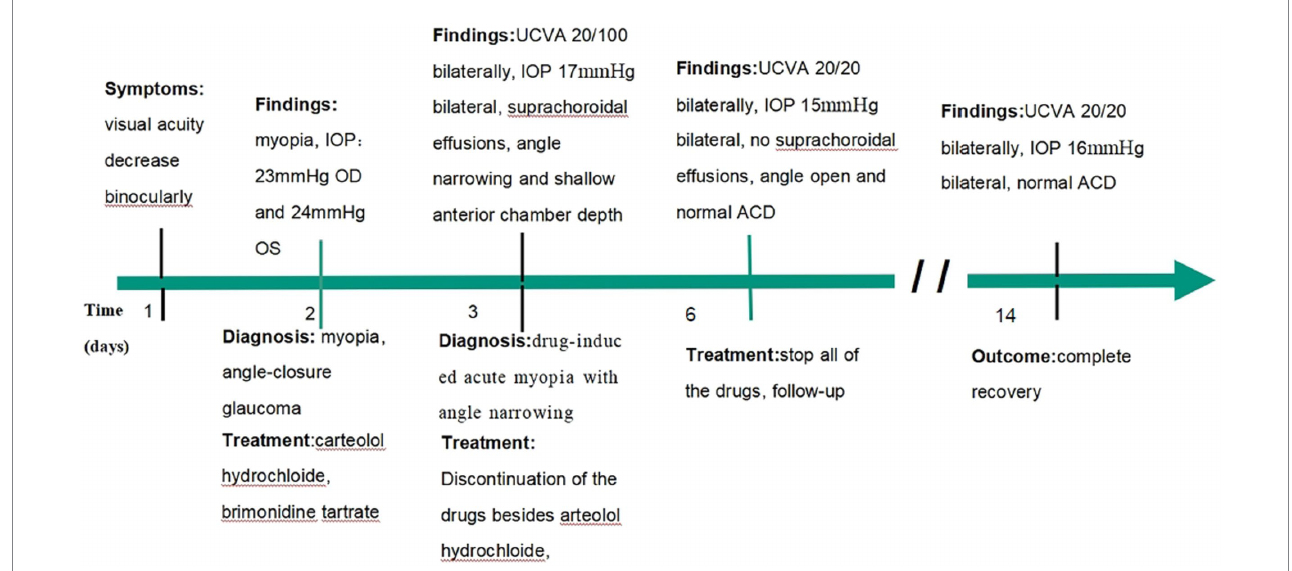
FIGURE 1 Timeline from start to resolution of acute myopic and angle narrowing induced by topiramate and